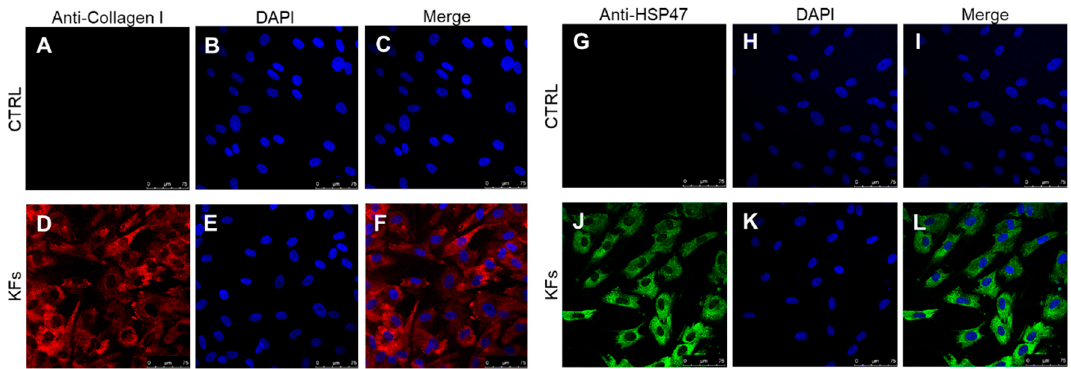
Figure 2. ( A – L ) Cultured keloid-derived fibroblasts (KFs) characterized by confocal microscopy. The use of selective markers such as type I collagen (in red) ( D ) and HSP47 (in green) ( J ) reveals the presence of fibroblast cells in primary cultures. All the visible nuclei (in blue) ( E , K ) co-localize with the type I collagen (in red) ( F ) or with HSP47 (in green) ( L ) in KFs. Control experiments were performed in both cases to verify type I collagen and HSP47 antibodies selectivity ( C , I ), respectively. Secondary antibodies were used without primary antibodies ( A , G ) and cultured cells were stained by DAPI ( B , H ). Scale bar: 75 µm.